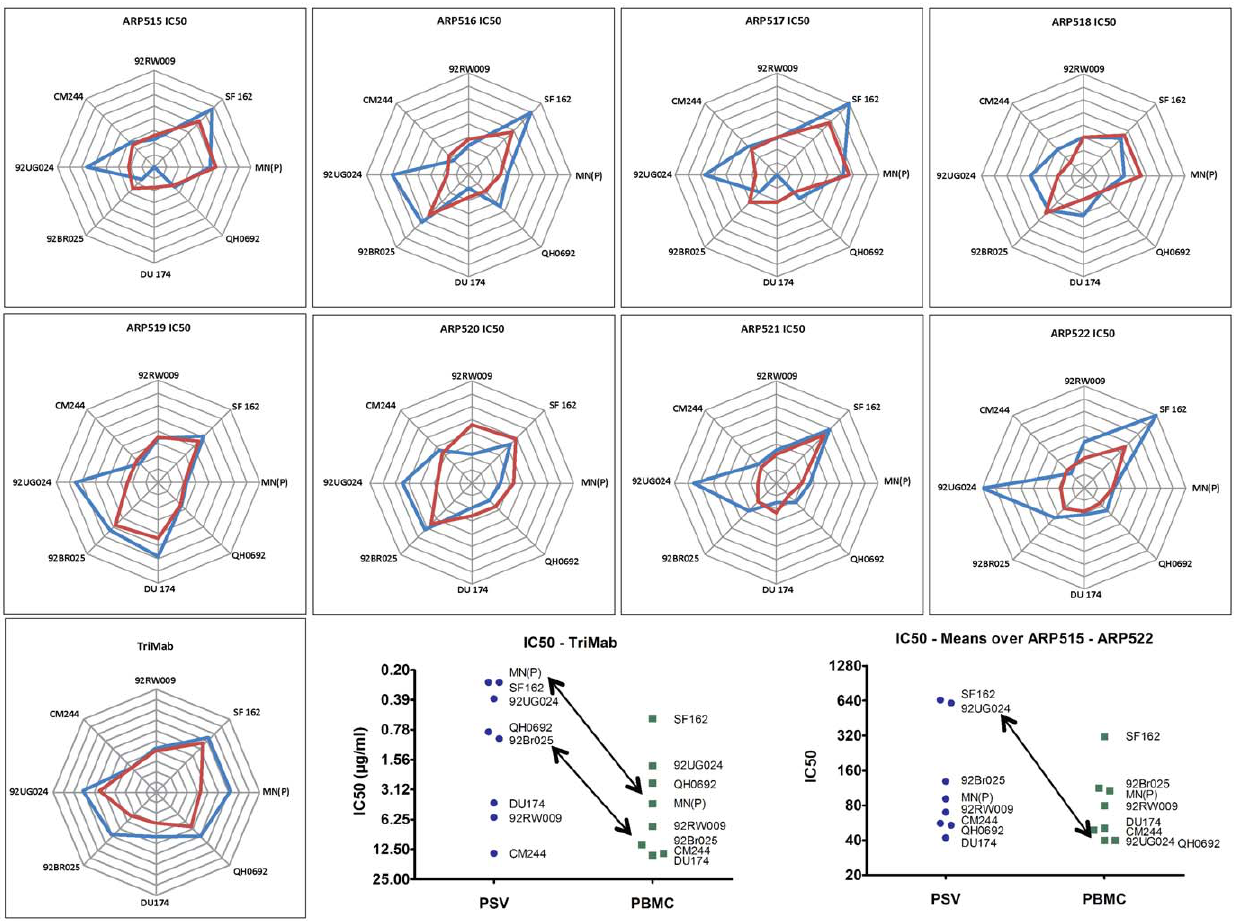
Figure 3. Comparison of PSV and VI assays across viruses. (A) circular ‘‘radar’’ plots. Lines from the centre represent an axis for each virus. The geometric mean IC value for PSV (blue lines) and PBMC (red lines) against each virus is plotted, and the points joined. The scale is set such that the centre represents no neutralization and the concentric grid-lines are 2-fold dilution steps moving out to highest neutralization at the edge. (B) and (C) Ranking of viruses for relative sensitivity to neutralization was done by calculating geometric mean IC50s across laboratories (grouping PSV and PBMC separately). (B) Ranking by TriMab and (C) ranking by plasma (means over ARP515-522). The scale is set such that the most neutralization sensitive viruses are at the